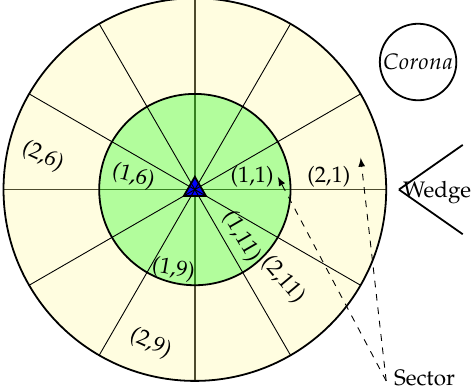
Wedge Sector Figure 4. Network with corona, wedge and sector. In order to send the sensing information to the BS, every wedge constructs a virtual path which 256 will join the outermost sector to the BS. A node then selected as a Head Node from a sector, and that 257 Head Node sends the cumulative traffic of its sectors, and its predecessors to its successors. Only one 258 node from a sector is used to forward the data to the BS, so MAC level contention is greatly reduced. 259